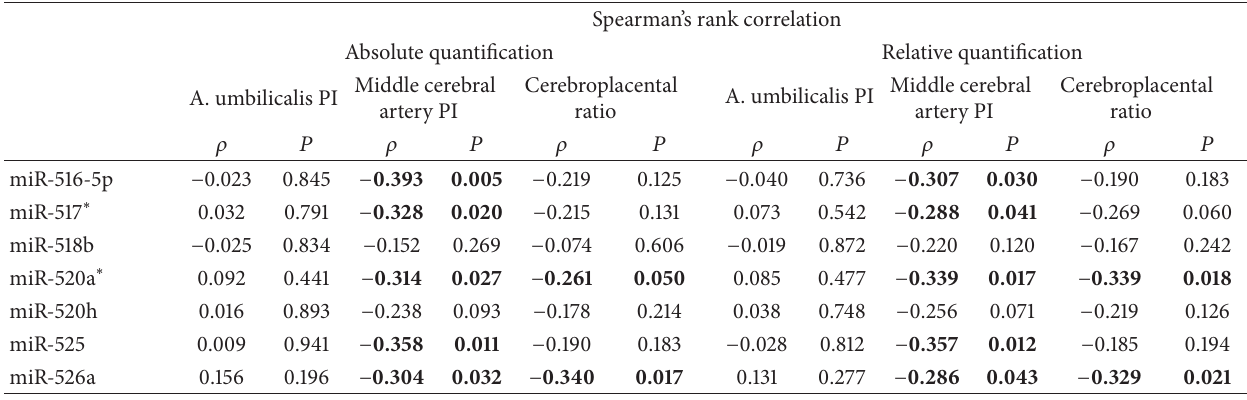
Table 1: Correlation between Doppler ultrasonography parameters and C19MC microRNAs expression levels and plasmatic